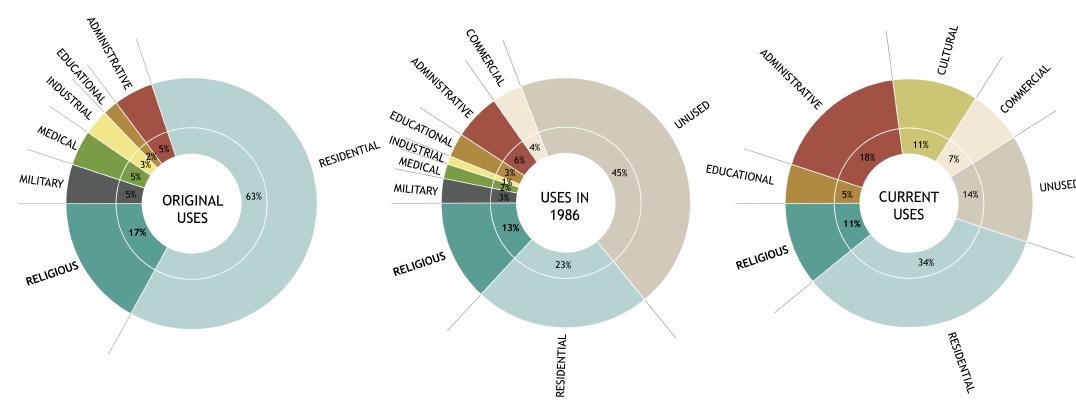
Figure 1: One hundred buildings uses in its origin, in 1986 and